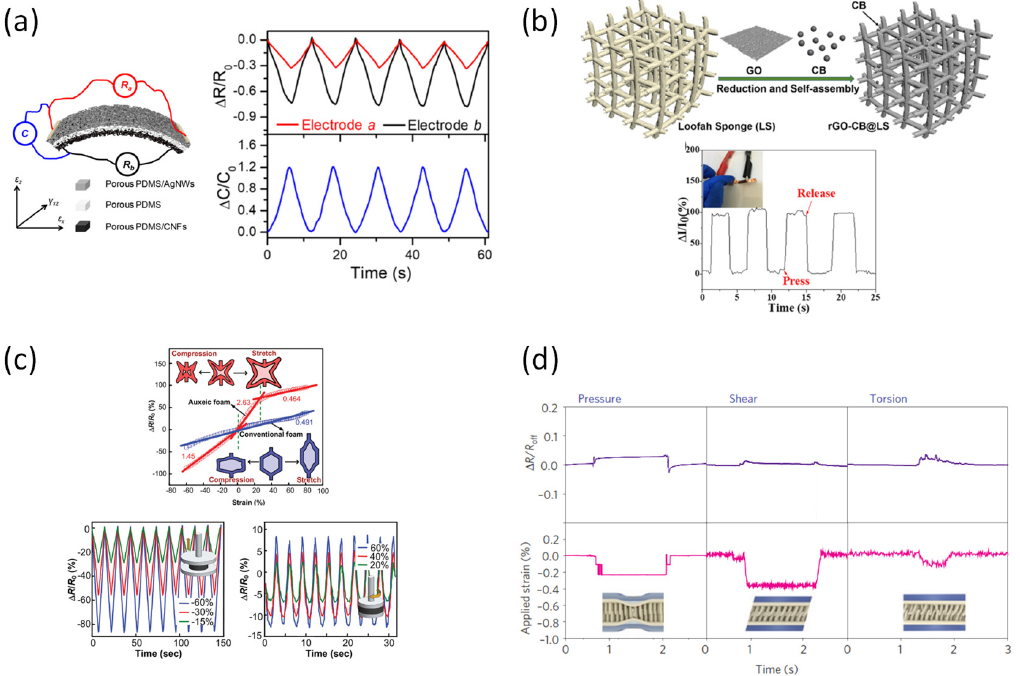
Figure 2. ( a ) Porous PDMS | PDMS/CNFs | PDMS/AgNWs piezoresistive sensor [50]. ( b ) Carbon black nanoparticles optimized 3D wearable graphene multifunctional piezoresistive sensor [51]. ( c ) Piezoresistive based CNT coated auxetic foams [52]. ( d ) Two interlocked arrays of high-aspect-ratio Pt-coated polymeric nanofibers supported on thin polydimethylsiloxane layer [53] .